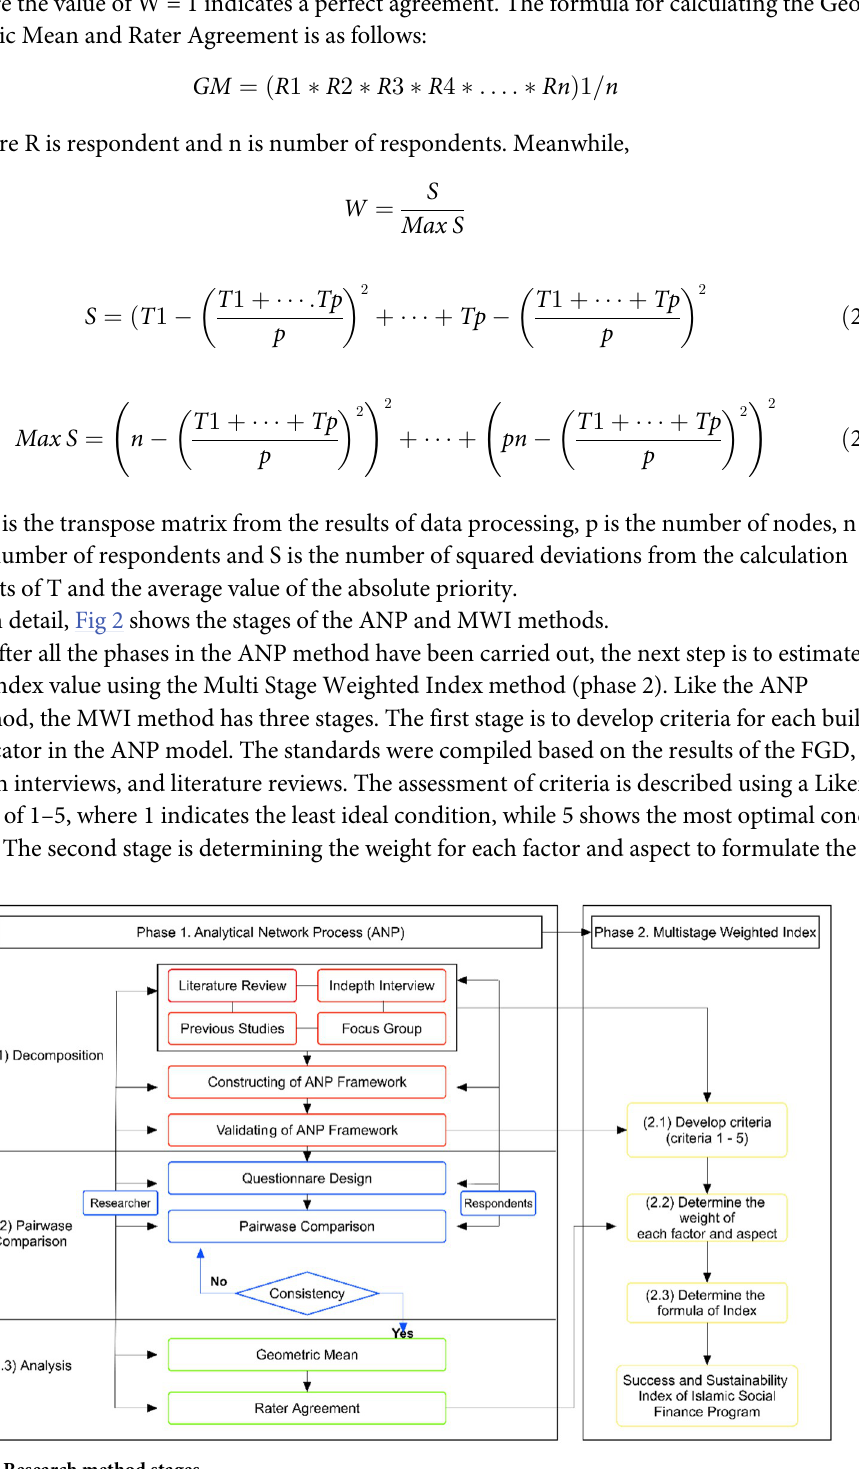
Fig 2. Research method